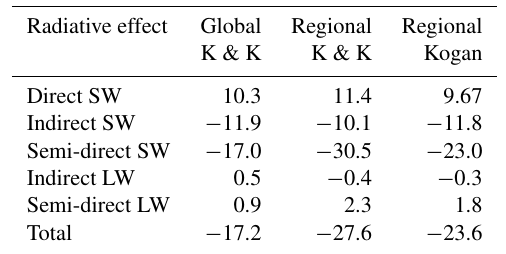
Table 3. Radiative effects of biomass burning aerosol, in units of watts per square metre (Wm − 2 ). The values shown are averaged over the polluted period of the simulations, 6–10 August 2016. We emphasise that the results are averaged over one of the most pol- luted periods in the 2016 fire season. As in Table 2, we present val- ues from the global model, and then from the regional models with the alternative parameterisations of autoconversion and accretion from (Kogan, 2013) and from (Khairoutdinov and Kogan, 2000) (labelled K &